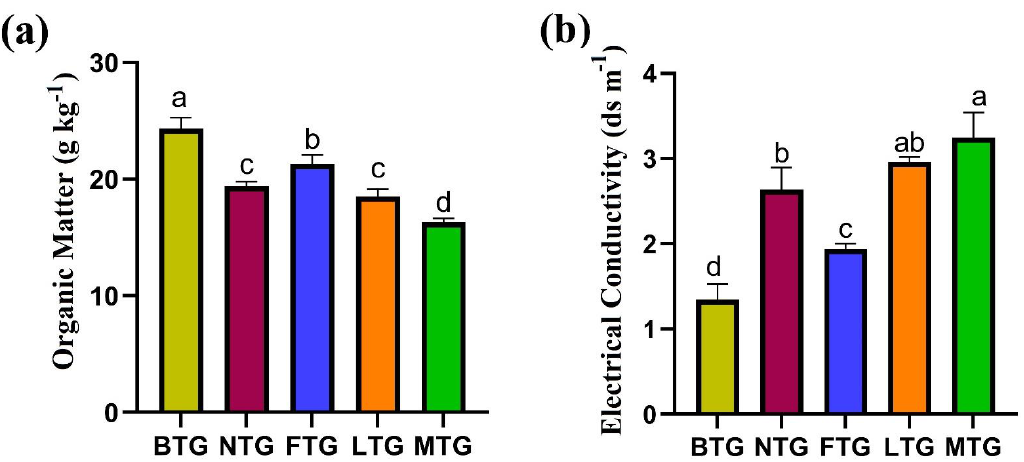
Figure 3. Effect of reduced soil pH on ( a ) OM (g kg −1 ) and ( b ) EC (dsm −1 ) on the tested gardens of BTG, NTG, FTG, LTG and MTG due to long-term traditional fertilization. BTG: BTRI Tea Garden, NTG: Nurjahan Tea Garden, FTG: Finlay Tea Garden, LTG: Lakkatora Tea Garden, MTG: Mal- nichara Tea Garden, OM: organic matter (g kg −1 ), EC: electrical conductivity (ds m −1 ). The statistics given are the averages of three replicates, with the vertical bars indicating the standard deviation. According to least significant difference test, the means signified by the same letter did not differ substantially at p < 0.05.